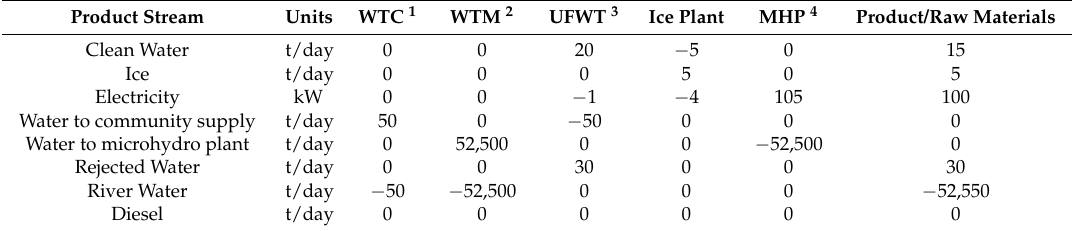
Table 1. The balanced process matrix of case study